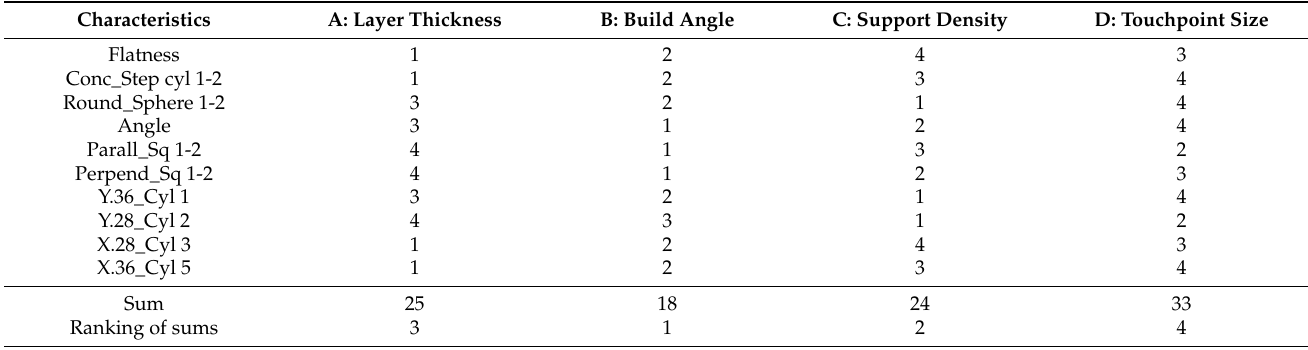
Table A2. Mean ranking of parameters for geometric characteristic of patterns.